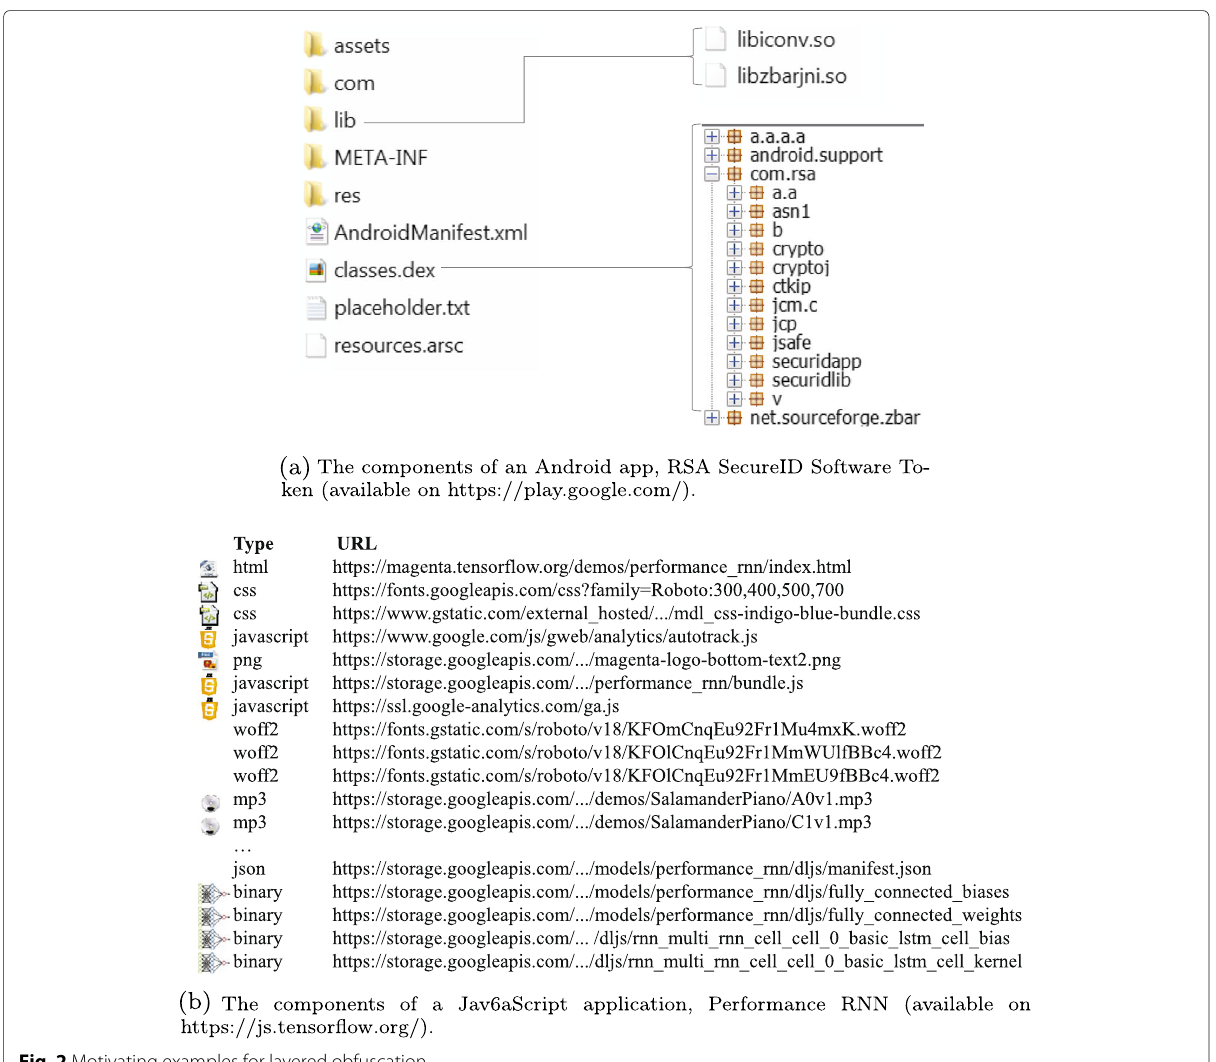
Fig. 2 Motivating examples for layered obfuscation